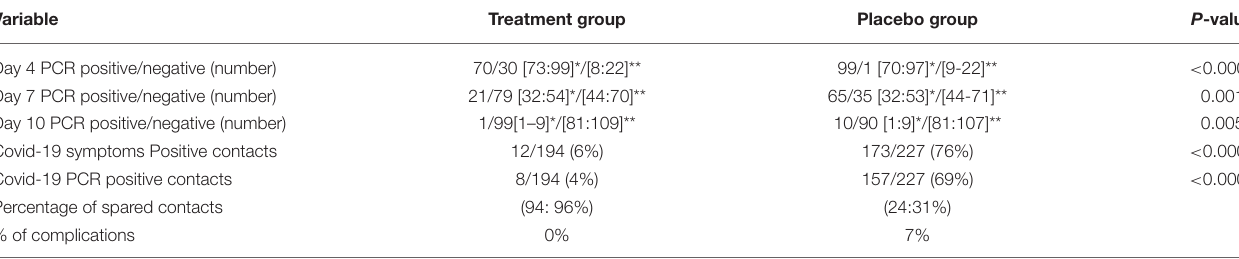
TABLE 2 | PCR for patients and positive contacts and percentage of complications of both treatment and placebo groups. Variable